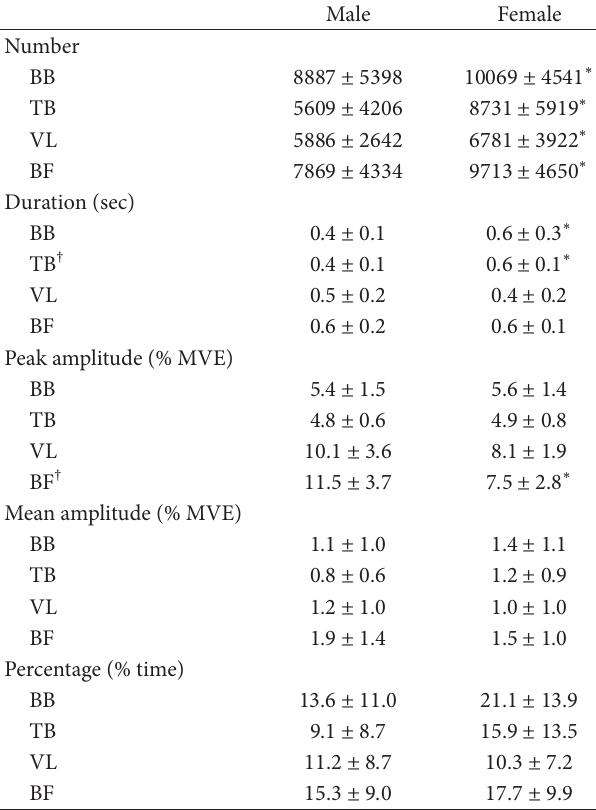
Table 2: Sex-related differences in burst characteristics for each muscle